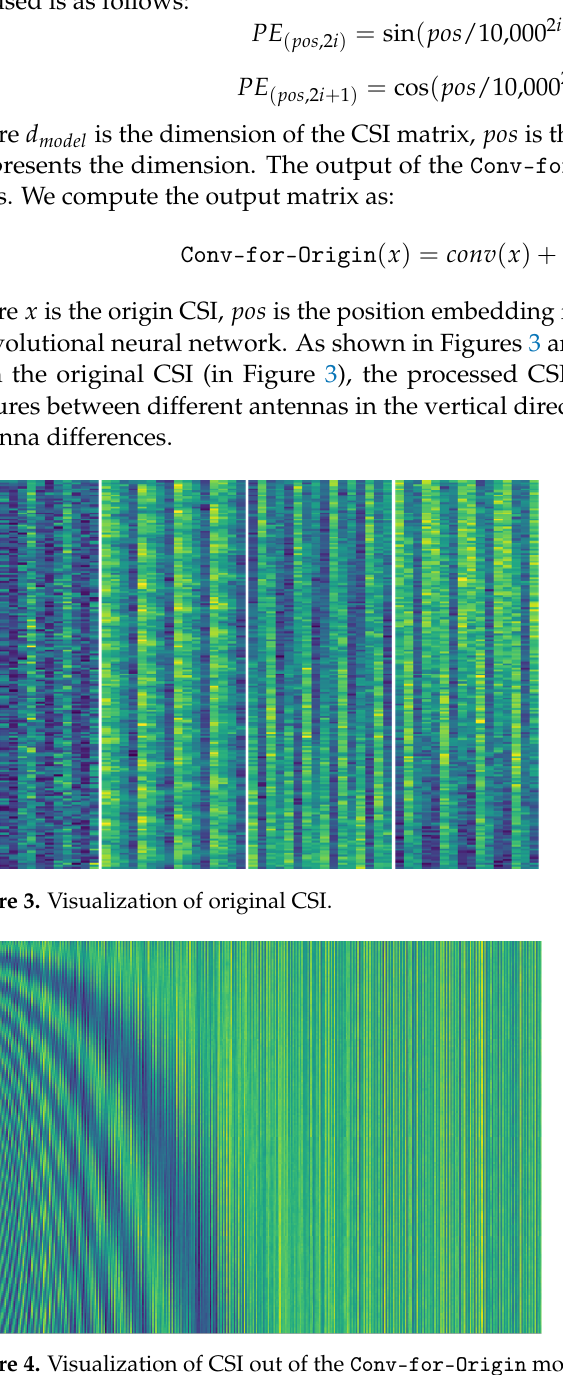
Figure 4. Visualization of CSI out of the Conv-for-Origin